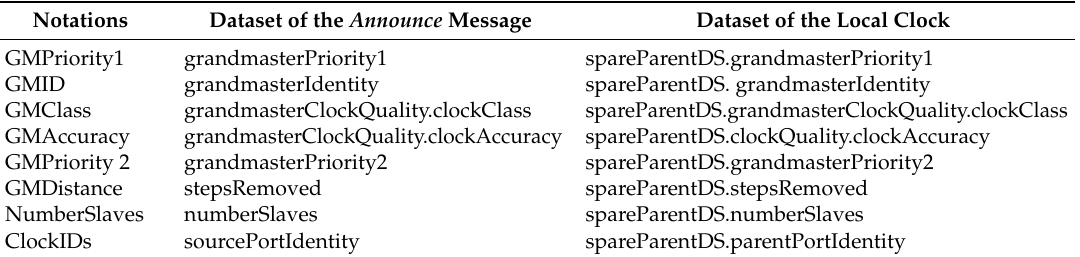
Table 3. Information sources for the dataset comparison used to select the spare master in the BSHSM algorithm.